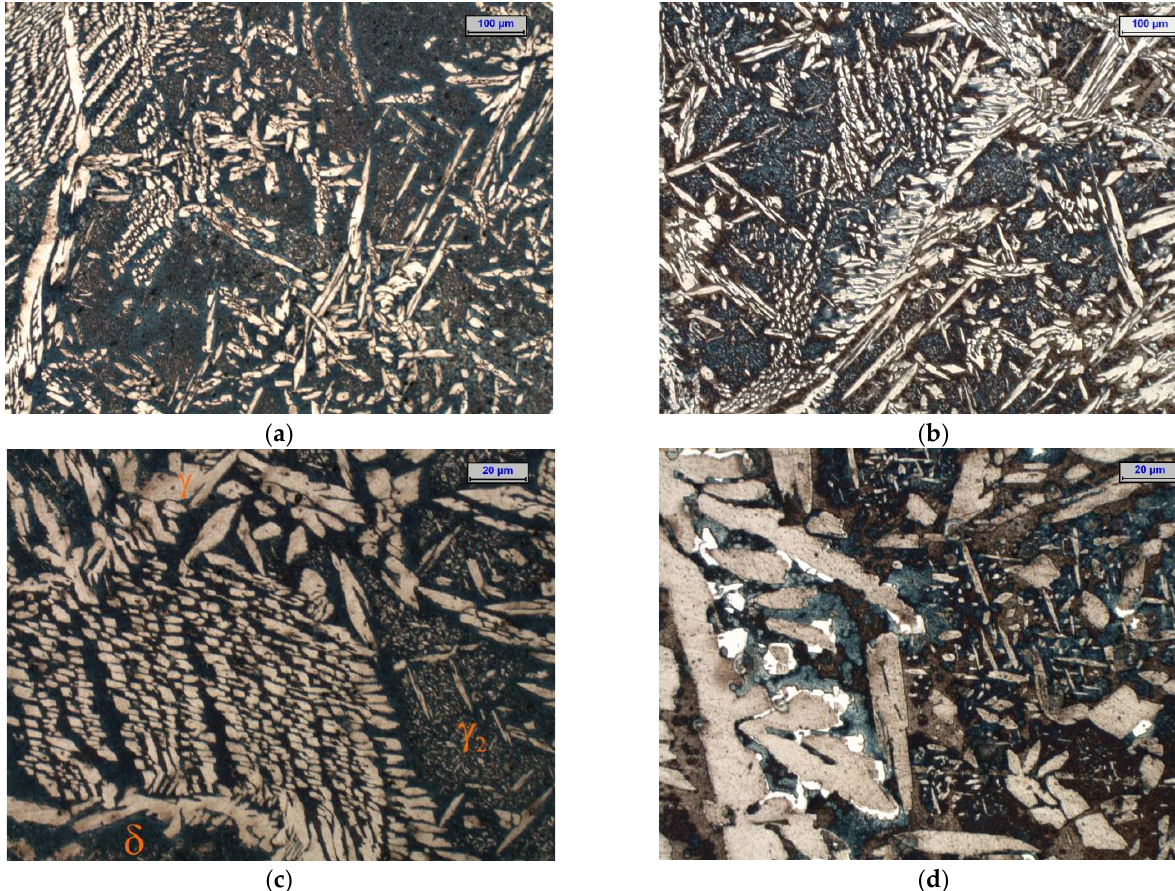
Figure 2. Microstructure of tested cast steel after isothermal holding for 1 h at 750 °C ( a , c ) and 900 ° C ( b , d ) —light microscope, etching with Beraha’s reagent (dark— ferrite; beige — austenite; white — σ phase and carbides); ( a , b ) — 100× magnification and ( c , d ) — 500× magnification.